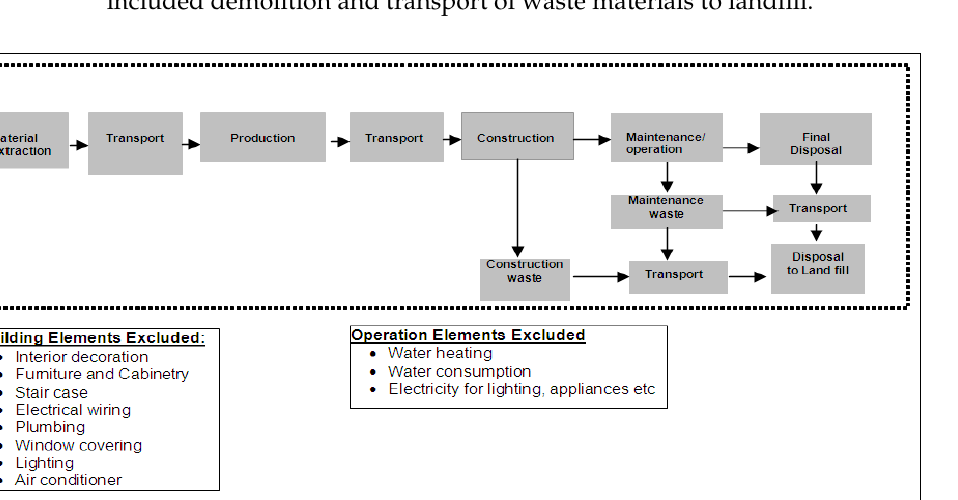
Table 7. Description of assemblages used to form different alternative houses.